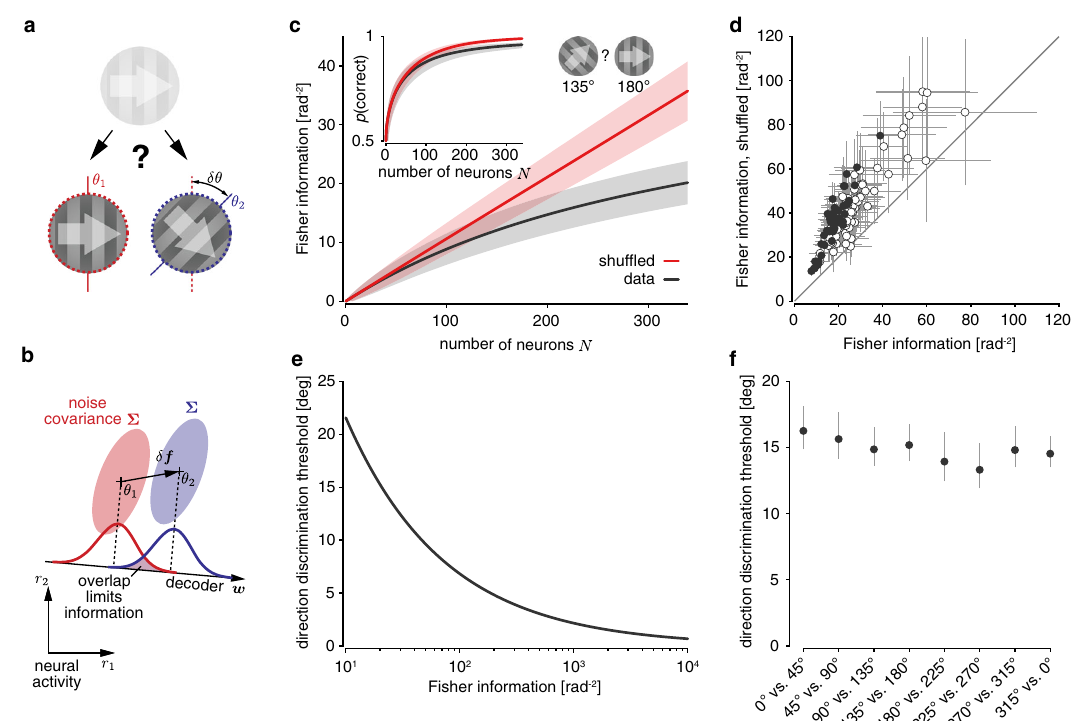
Fig. 3 Noise correlations limit information across all drift directions. a A drift direction discrimination task, in which a hypothetical observer needs to judge which of two template drift directions ( θ 1 or θ 2 ; indicated by white arrows) an observed low-contrast drifting grating corresponds to. b Mean activity f (crosses) and noise covariance Σ (shaded area ≈ 2SDs) of a pair of neurons across repeated presentation of the same two drift directions, θ 1 (red) and θ 2 (blue). Linear information about drift direction is limited by the projection of the noise onto the optimal linear decoder w . This decoder depends on how mean activity changes with drift direction ( δ f = f ( θ 2 ) − f ( θ 1 )) and the noise covariances Σ . c The information associated with discriminating between drift directions 135 ° and 180 ° scales sublinearly with population size (black; mean ± 1 SD across random orderings of neurons within the population). If we remove noise correlations by shuf fl ing trials across neurons, the information scales linearly (red). This linear growth would not be apparent from the probability of correctly identifying the stimulus ’ drift direction (inset), which is monotonically, but non-linearly related to Fisher information, and saturates in both cases. d Information in the recorded population was consistently larger for trial-shuf fl ed data across different discriminations, sessions, and mice. Each dot (mean ± 1 SD of information estimate; fi lled = signi fi cant increase, bootstrap, p < 0.05) shows the information estimated for one discrimination with δθ = 45 ° . e The drift direction discrimination threshold (corresponding to 80% correct discriminations) we would expect to see in a virtual discrimination experiment drops with the amount of information that V1 encodes about drift directions. f The inferred drift direction discrimination threshold for the same session as in panel c is comparable across the different drift direction pairs with δθ = 45 ° used to estimate Fisher information with the recorded